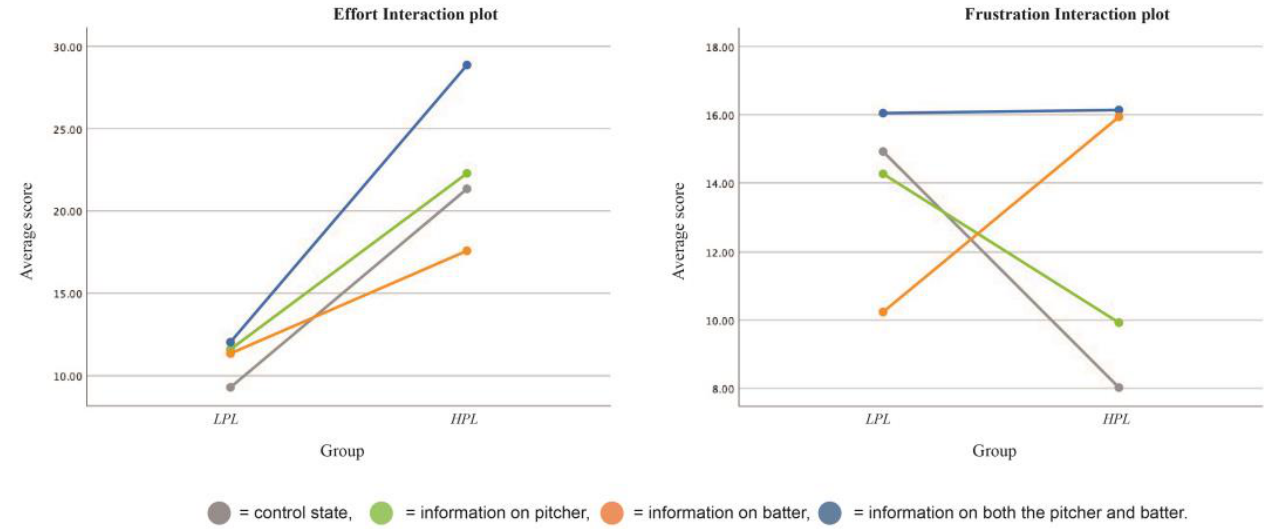
Figure 4. NASA-TLX e’s Interaction Figure 4. NASA- TLX e’s Interaction plot.